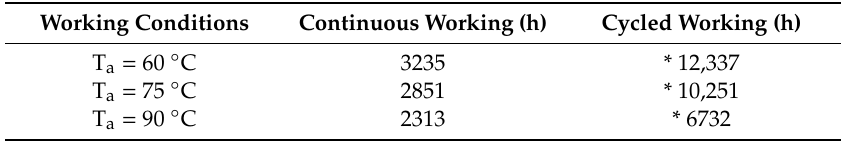
Figure 3. Normalized optical power evolution of four UV LEDs tested at T a = 75 °C in temperature accelerated life tests (ALTs). LEDs in continuous working mode (Con. W.) are indicated by a continuous line; UV LEDs in cycled working mode (30 s on / 30 s of) (Cyc. W.) are indicated by a dashed line. In the figure, 75-1 to 75-4 are the IDs of the UV LEDs. Table 2. Average instant of failure of temperature accelerated tests and working conditions. Values indicate time in the climatic chamber. * Cycled working condition failure instant was extrapolated.